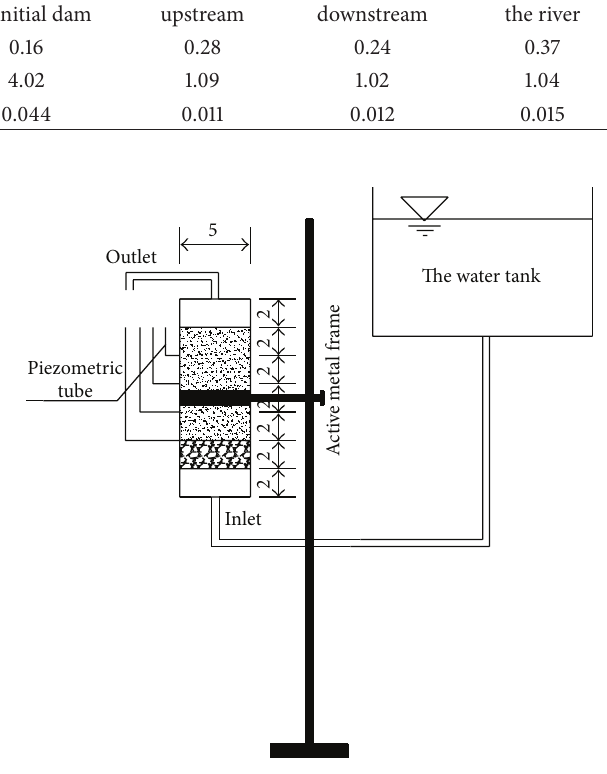
Figure 4: Physical clogging experimental setup (all distance num- bers in the figure are in